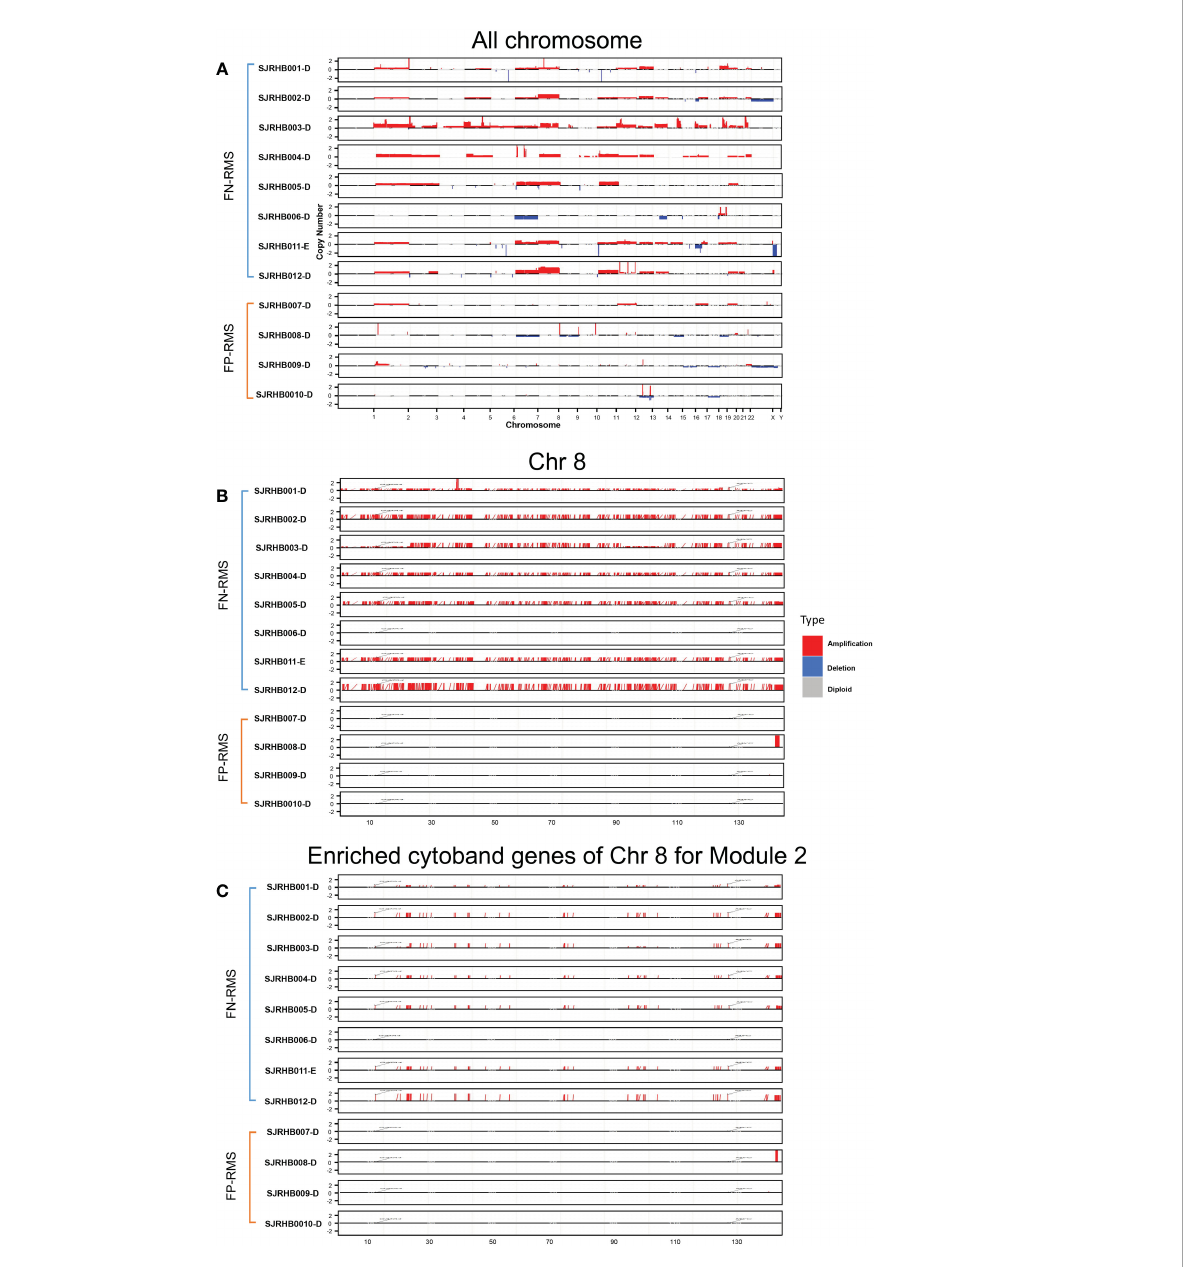
FIGURE 4 CNV distribution in FN-RMS vs. FP-RMS of St. Jude dataset. (A) is for entire genome, (B) is for chromosome 8, and (C) is for enriched cytoband genes of chr 8 for Module 2 from discovery